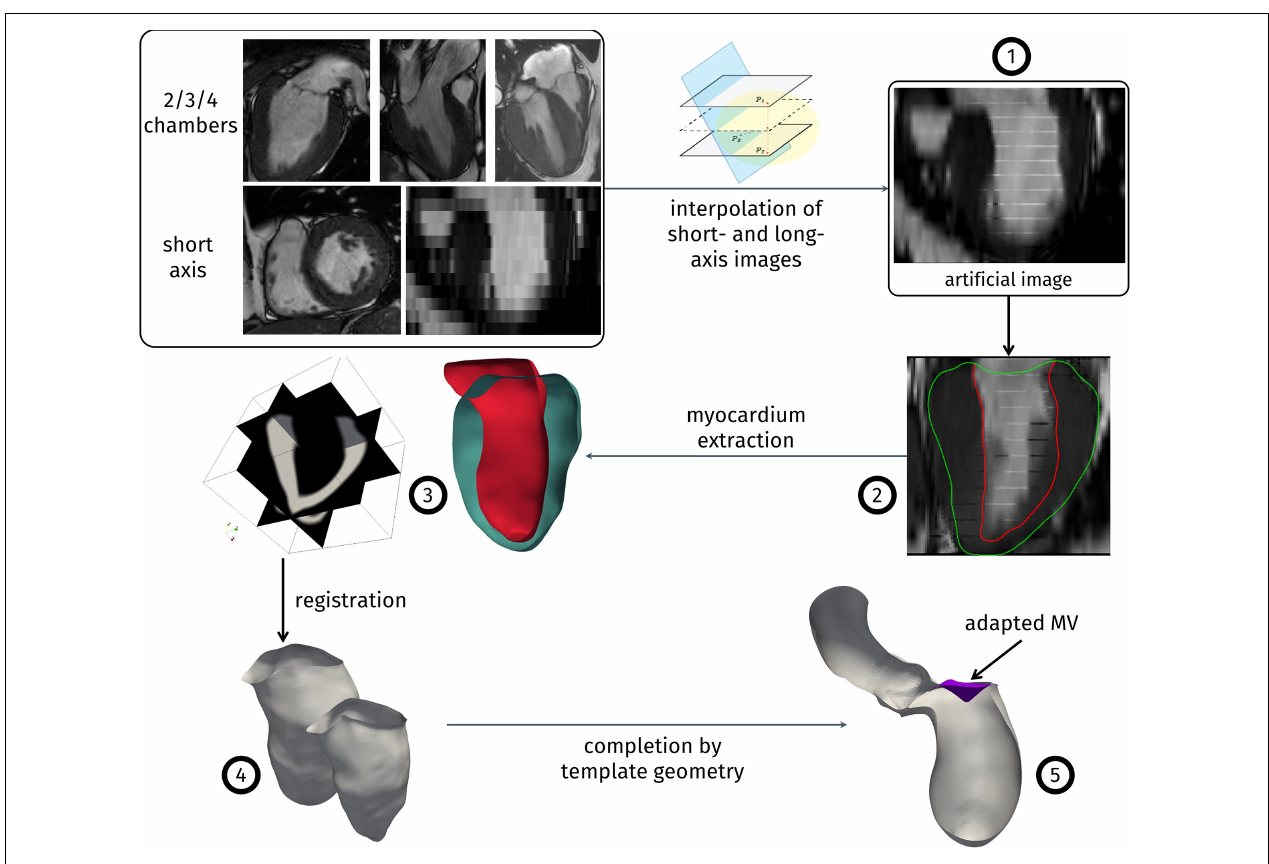
FIGURE 1 | Reconstruction algorithm. Numbers correspond to the steps of Algorithm